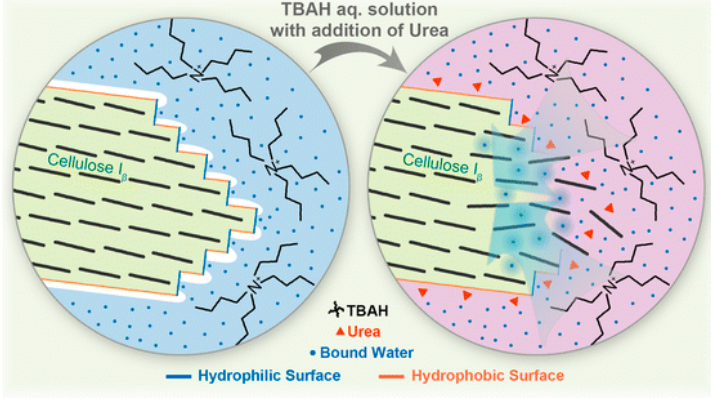
Figure 8. Schematic representation of the mechanism for dissolution of cellulose in TBAOH/urea aqueous solution; reprinted with permission from [154], Copyright (2013) Springer Nature.